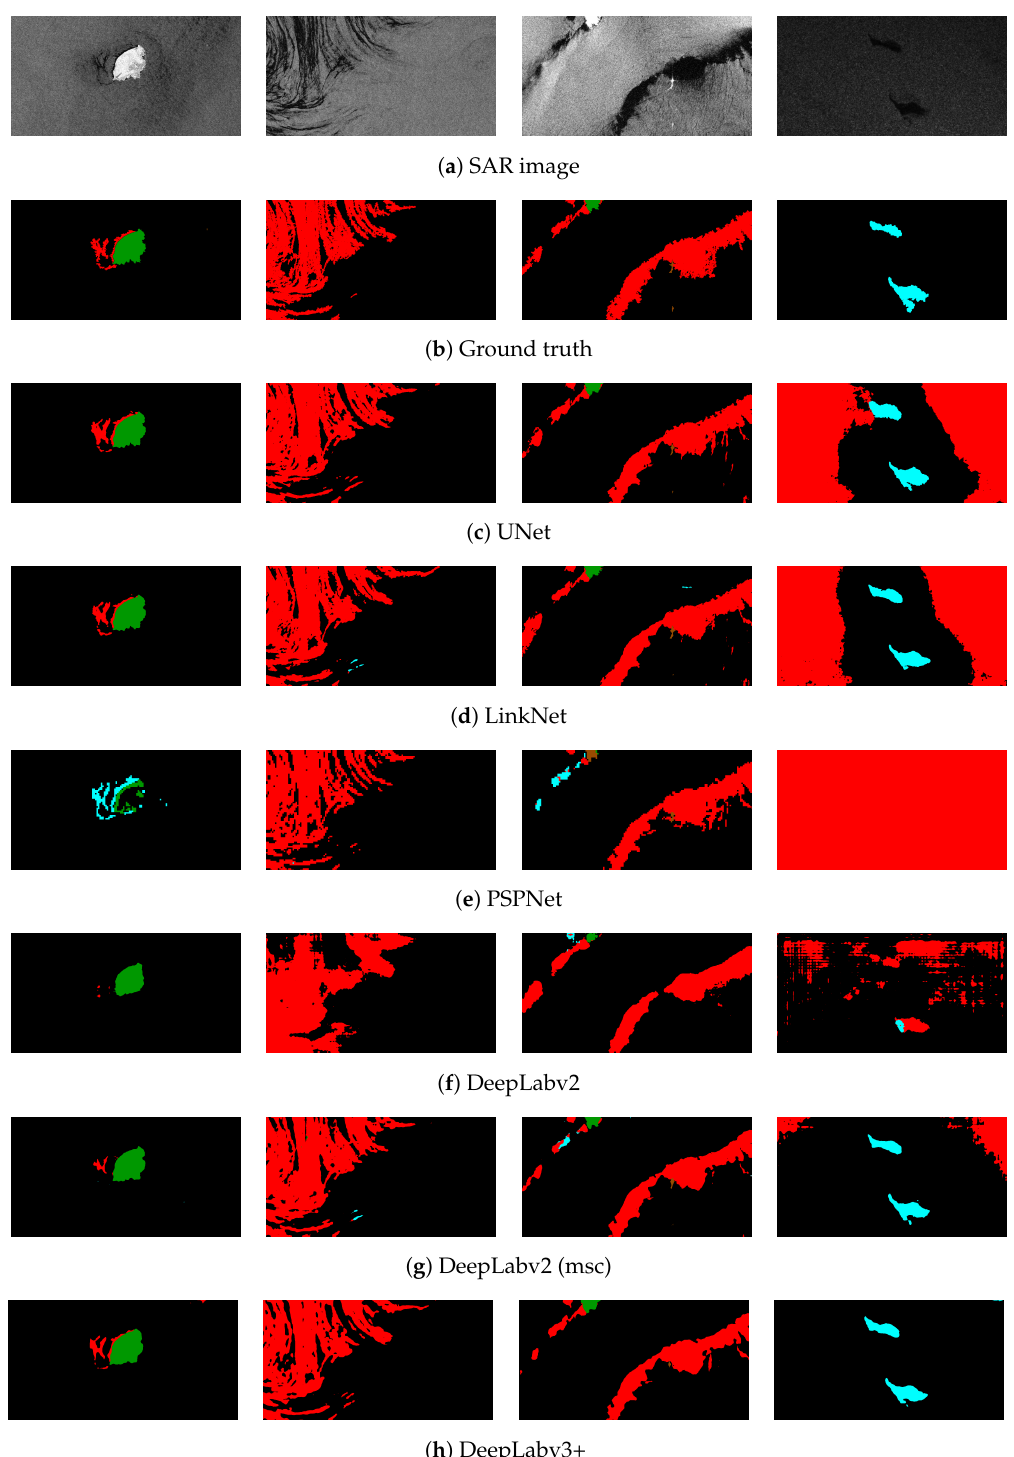
Figure 9. Example 2 of qualitative results of the examined segmentation models on the presented oil spill